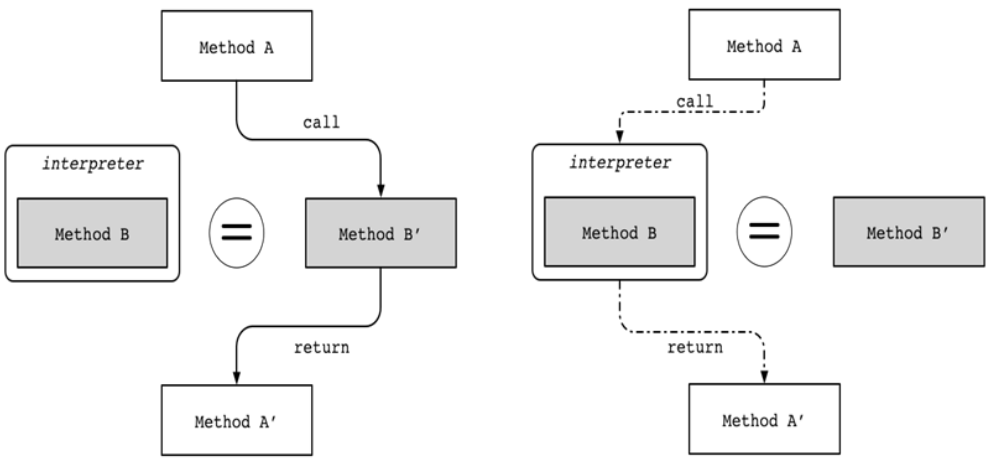
Figure 12. Execution flow at normal execution ( left ) and at debugging ( right ).